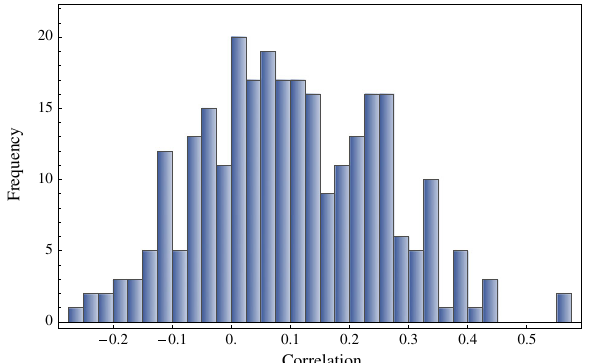
FIG. 2 (color online). Histogram of the Pearson’s r correla- tions between all 276 question pairs from the post-test data. The correlations are calculated using Eq. (6), with the p from the